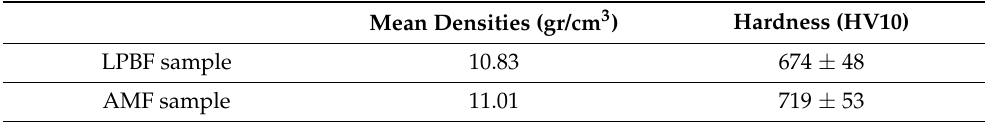
Table 9. Mean densities and hardness of HEa WTaMoNbV obtained by LPBF vs. its counterpart alloy produced by AMF